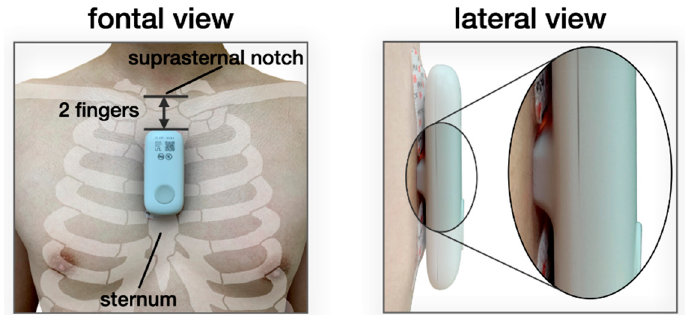
Figure 2. From the frontal view, the wearable patch biosensor is attached to the sternum of the subject using ECG electrodes. The superior end of the device starts approximately two fingers down from the suprasternal notch. From the lateral view, the protruded part of the device that houses the LEDs and PDs is visible. Note that light is hardly visible from the sides of the device.